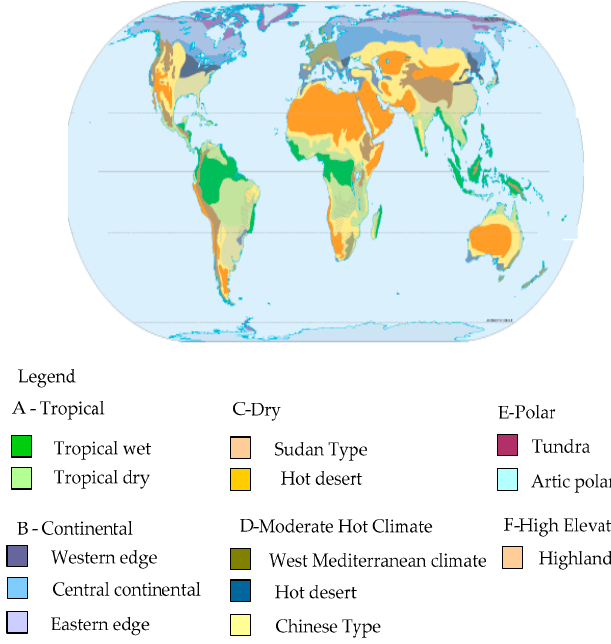
Figure 1. World climate overview.